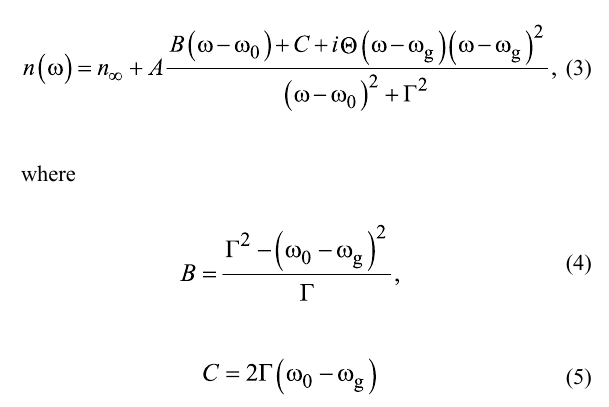
Ascertained of the high photocatalytic activity of the Ti (430- 190) sample due to its structural and optical properties,